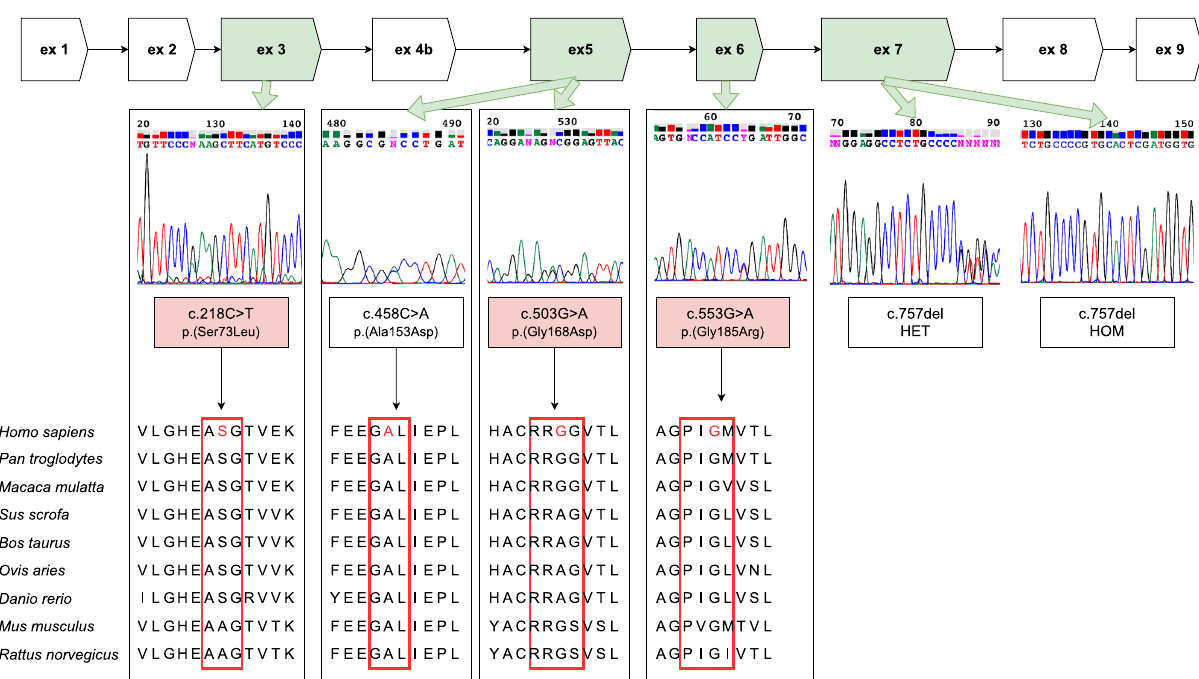
Figure 3. Variants in the SORD gene detected in this study. Upper part - The structure of the SORD gene with nine coding exons. Middle part - Sanger sequences of variants detected in the study; detected novel variants are in pink. HET - hetrozygous; HOM-hoomzygous. Lower part - The conservation of amino acids based on a multiple sequence alignment analysis for missense variants detected in the study (https:// www. ebi. ac. uk/ Tools/